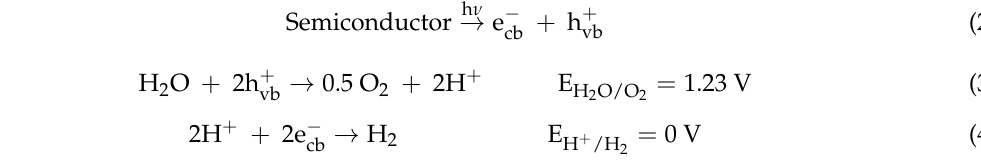
Figure 3. Photocatalytic reforming of organic species. In accordance with microscopic reversibility, catalysts promote both direct (i.e., water dissociation in photosplitting and organic oxidation in photoreforming) and reverse reactions. In such photocatalytic systems, oxygen competes with protons in photogenerated electron capture, thus impairing hydrogen generation. In order to avoid the presence of oxygen in the reacting mixture and also suppress hydrogen-oxygen recombination reaction, purging the reacting system with an inert gas is an effective strategy. A number of heterogeneous semiconductors possessing some of the above-mentioned requirements has been so far developed for the photocatalytic hydrogen generation. The most commonly-used metallic elements are mainly in the form of oxides or sulfides [17,22]. It should be observed that such elements are adopted in their highest oxidation state (Ti 4+ , Zr 4+ , Nb 5+ , Ta 5+ , W 6+ , Ce 4+ , Ga 3+ , In 3+ , Ge 4+ , Sn 4+ , Sb 5+ ) [19]. Transition-metal cations with empty d or f orbitals have a d 0 and f 0 electronic configuration, respectively, whereas metal cations with filled d orbitals possess a d 10 electronic configuration. In order to develop novel visible-light-active photocatalysts with increased quantum efficiency, doping semiconductor materials with selected transition-metal elements, acting as co-catalysts